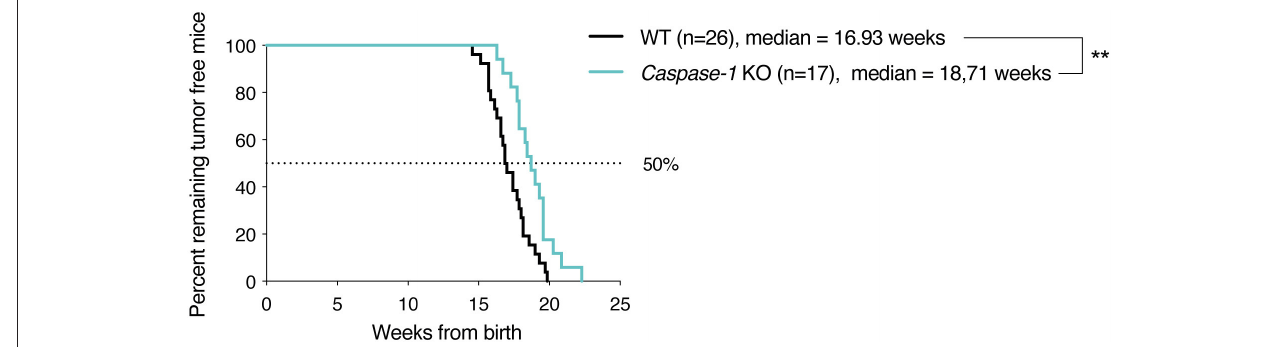
FIGURE 1 | Caspase-1 deficiency delays tumor appearance in MMTV-Neu V 664 E BALB/c mouse model. Kaplan–Meier curves depicting tumor growth latency of MMTV-Neu V664E mice, defined as time from birth until appearance of the first palpable tumor. ** P < 0.01 (Comparison of survival curves: Gehan–Breslow–Wilcoxon test).